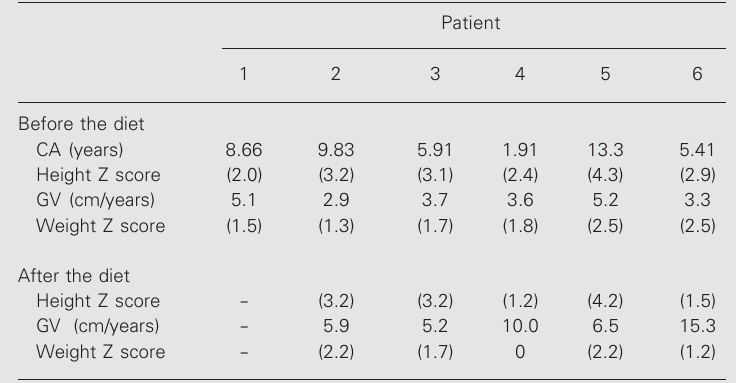
Table 4. Clinical data before and after the introduction of a gluten-free diet for subjects with duodenal abnormalities (group